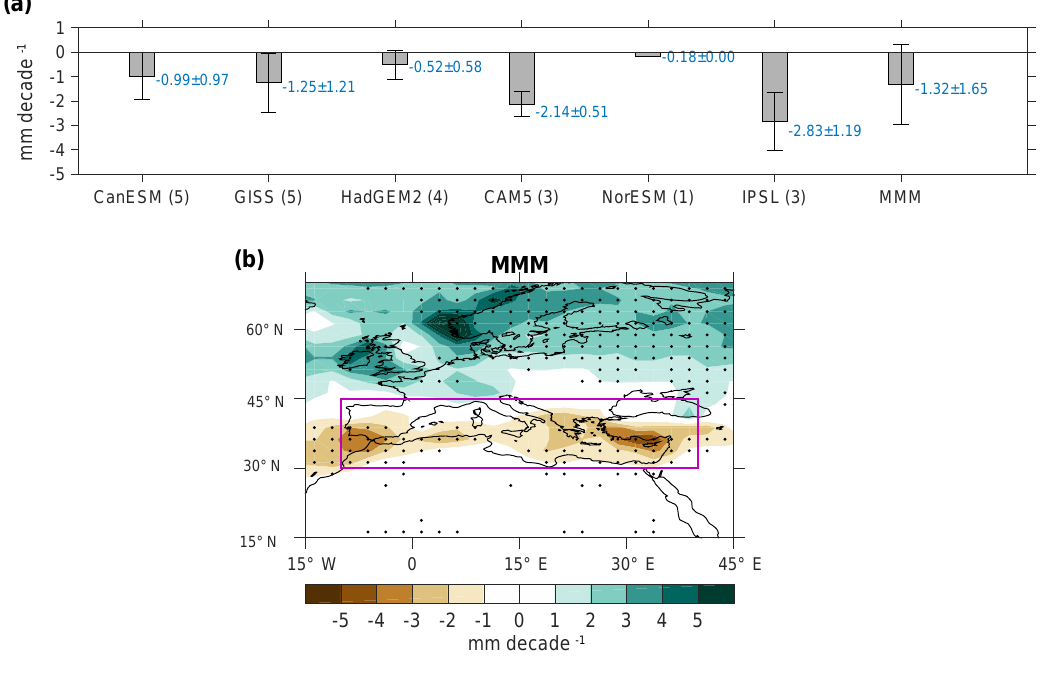
Figure 8. Precipitation trends of CMIP5 “historicalGHG” simulations during 1901–2005; (a) domain-averaged (purple rectangles in Fig. 1) trends for each model. Error bars of each model indicate 90% inter-ensemble spread and error bars of MMM indicate the 90% inter-model spread. The numbers in parentheses indicate the ensembles collected for each model. (b) Spatial pattern of MMM value for the trends. Dots indicate that the change is significant at 0.95 confidence